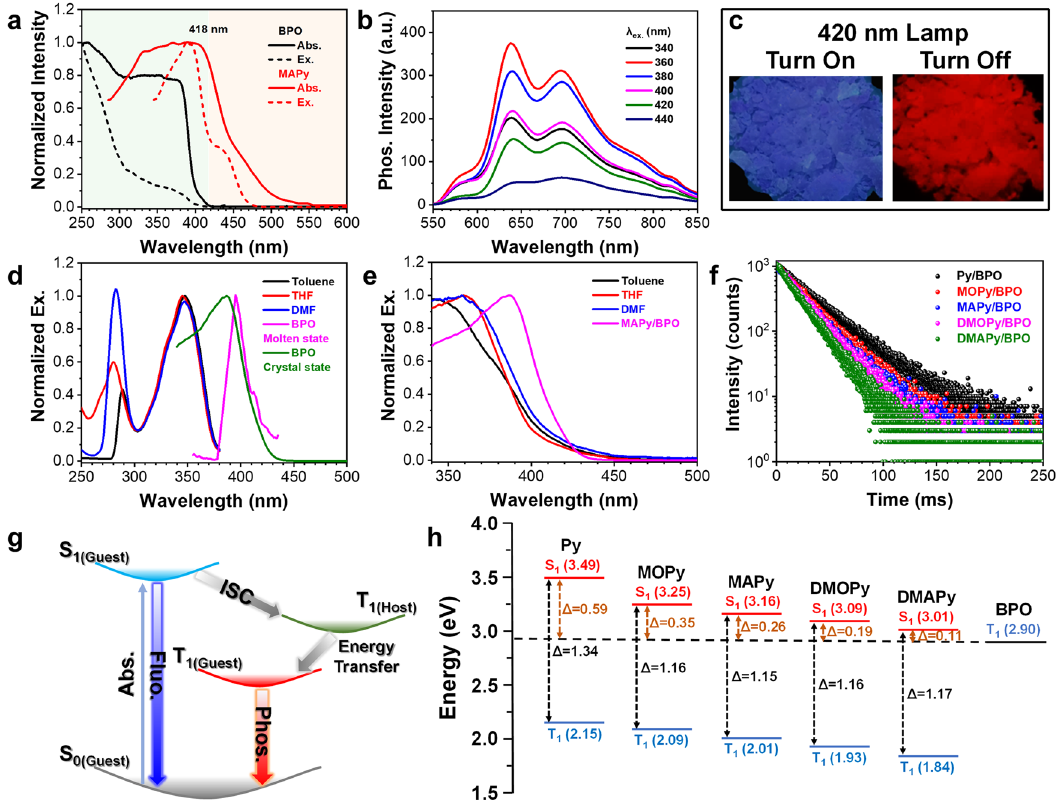
Fig. 5 Energy transfer between guest and host. a Excitation spectra of host BPO powder and guest MAPy powder. b Phosphorescence spectra of guest – host material MAPy/BPO at different excitation wavelengths. Excitation wavelength: 380 nm; Delayed time: 1 ms. c Luminescence photos of the MAPy/BPO powder. Excitation spectra of fl uorescence ( d )/phosphorescence ( e ) of MAPy in different solvent and molten state host (Concentration: 1 × 10 − 4 mol/L). f Phosphorescence decay curves of the guests in 77 K (Ex: 380 nm; Concentration: 1 × 10 − 4 mol/L; Solvent: 2-methyltetrahydrofuran). g Proposed transfer path between guest and host. h The energy levels of BPO and fi ve